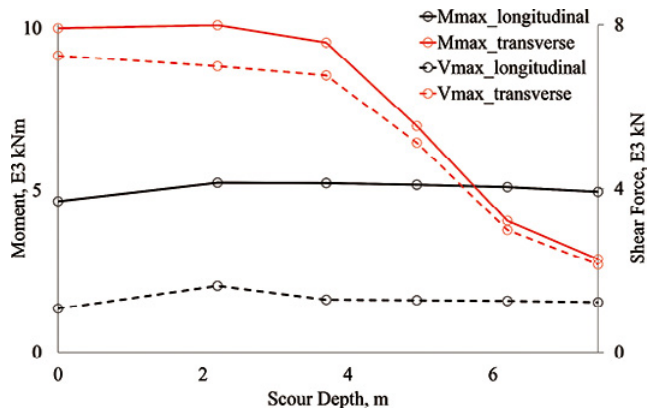
Figure 7. The variation of the maximum internal forces with scouring